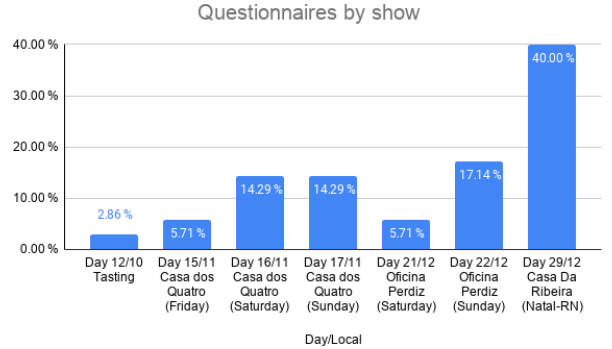
Figure 3. Histogram of audience and